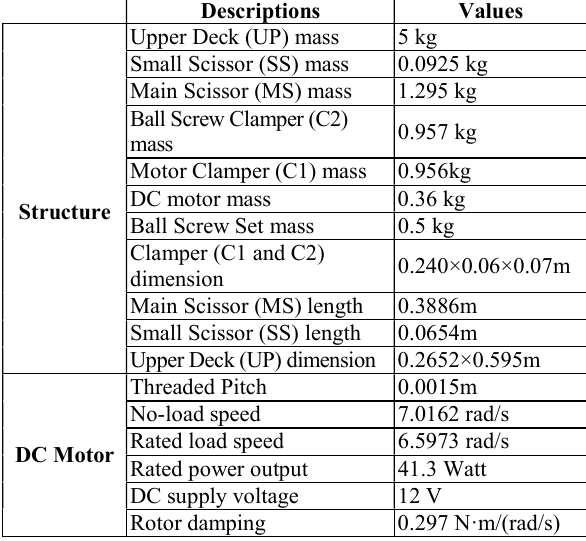
Figure 4. Scissor mechanism platform system: (a) location of the infrared sensor and (b) control system configuration in the Real-Time Window Target application